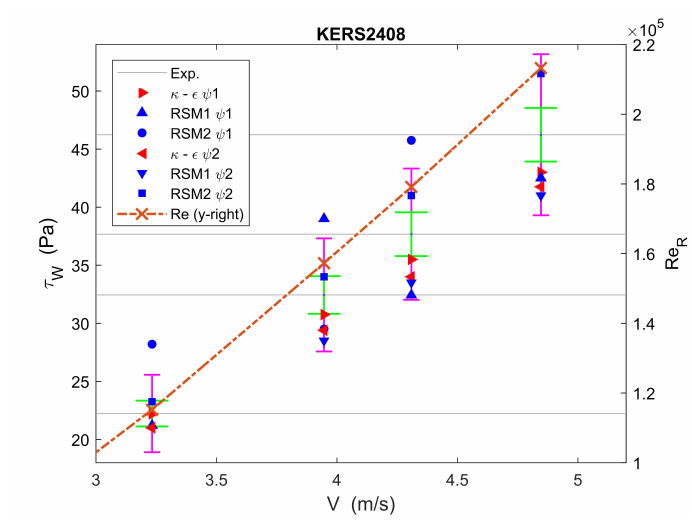
Figure 14. τ y = 1.04 Pa, m = 0.0136 Pas n , n = 0.8031 and D = 79 mm.